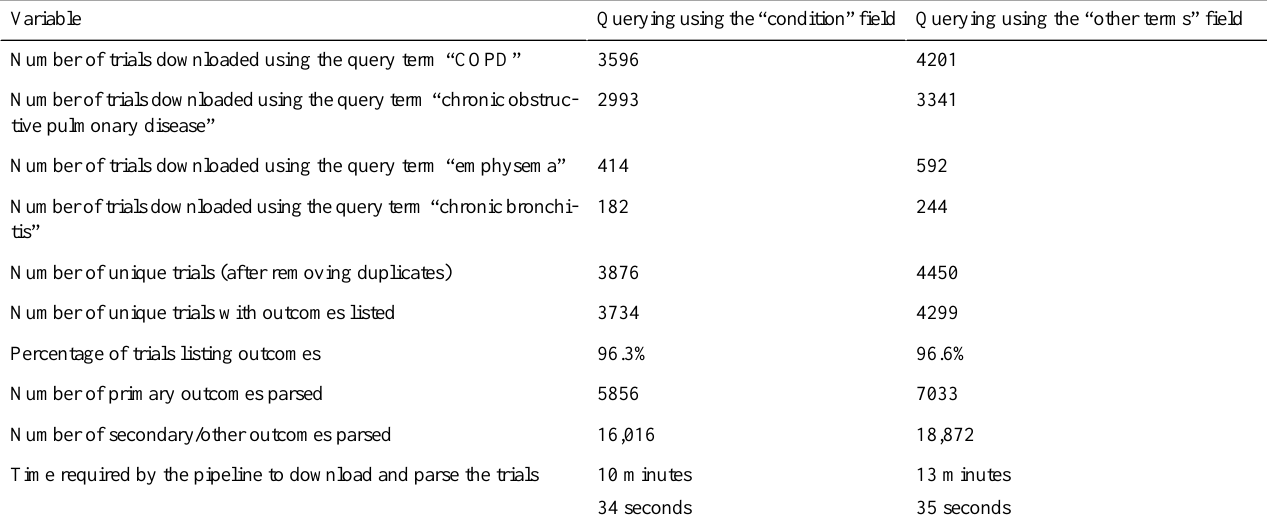
Querying using the “other terms” fieldQuerying using the “condition” fieldVariable